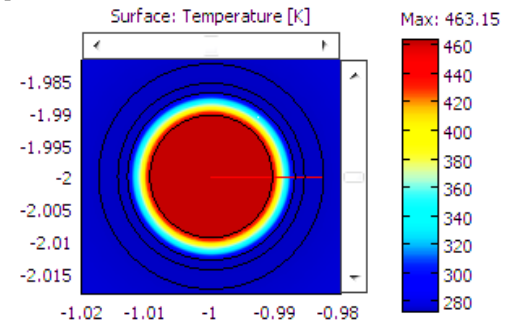
Figure 4. Gradient of temperatures on the section Results of calculation of the set mode (Figure 5) caused by the different current proceeding on a vein distinctly show weak, almost zero, dependence of distribution of temperature of high- heat-conducting elements − a vein and the screen of a cable (horizontal regiments on schedules). Thus in volume of isola- tion is observed the big gradient of temperatures that leads to an essential difference of temperatures of the screen of a cable where temperature sensors and the central vein are installed.